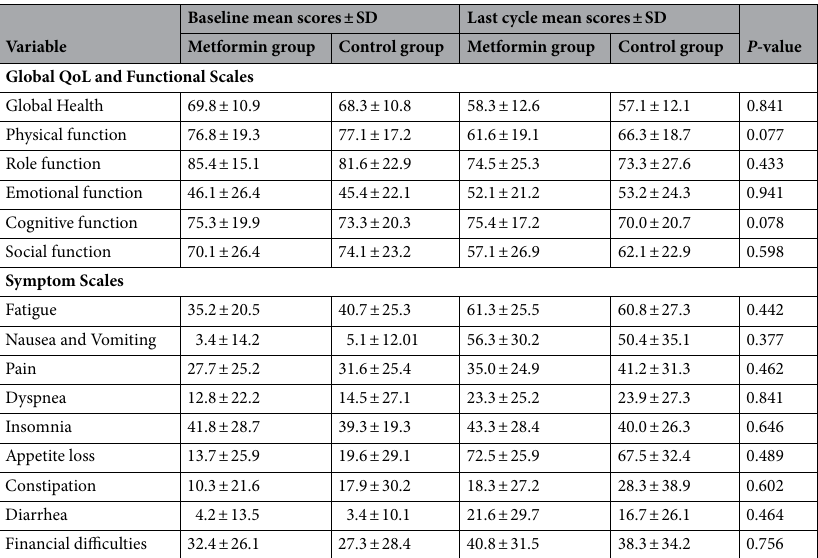
P -valueMetformin group Control group Metformin group Control group